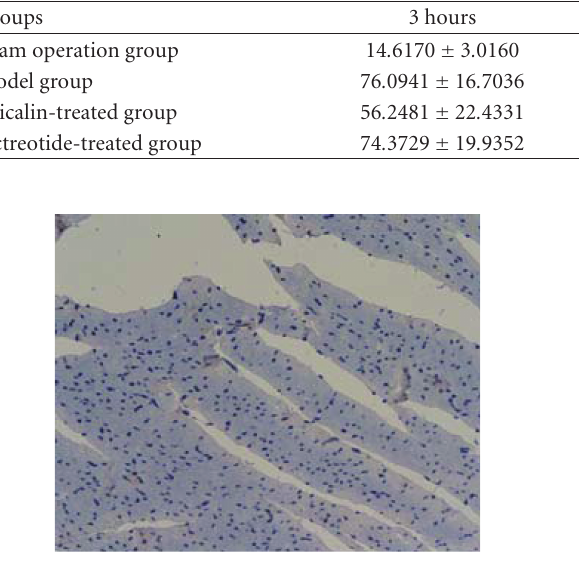
Figure 1: Octreotide-treated group-12h NF- κ B × 200 (negtive ex- pression).